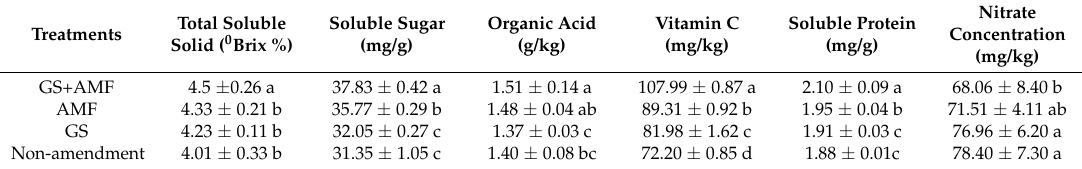
Table 5. Cucumber fruit quality indices in sprig of 2018 in the amended and non-amended treatments under PGVC soil.